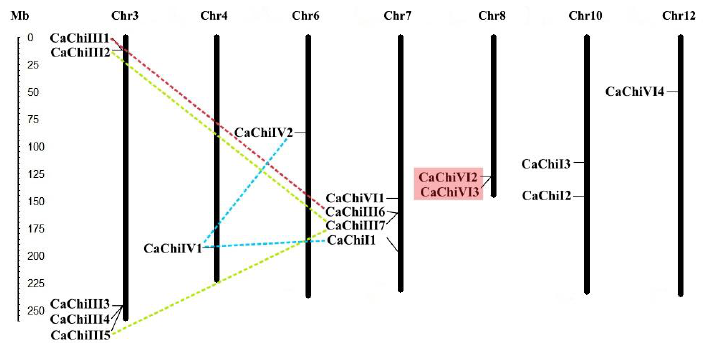
Figure 4. Chromosomal localization of CaChi of pepper plant, where the red shading box represents the tandem duplicated region. While the red, green and blue lines connection displaying segmentally duplicated